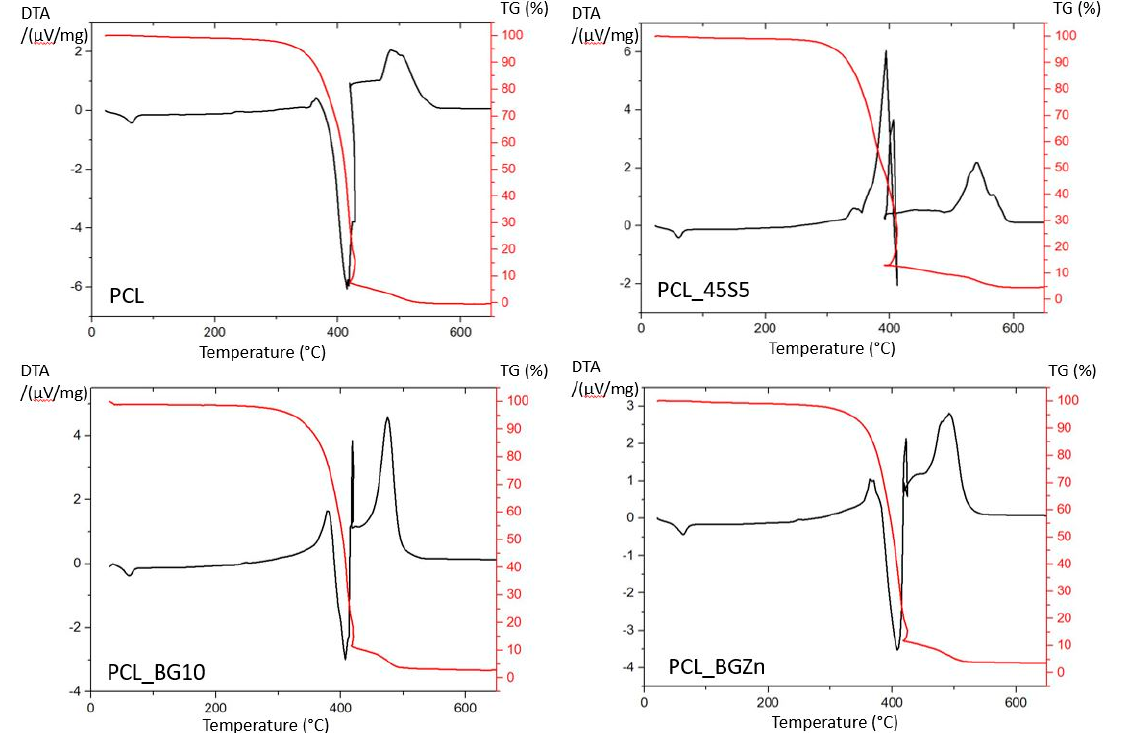
Figure 5. TG/DTA analyses of PCL, PCL_45S5, PCL_BG10, and PCL_BGZn. Figure 5. TG / DTA analyses of PCL, PCL_45S5, PCL_BG10, and